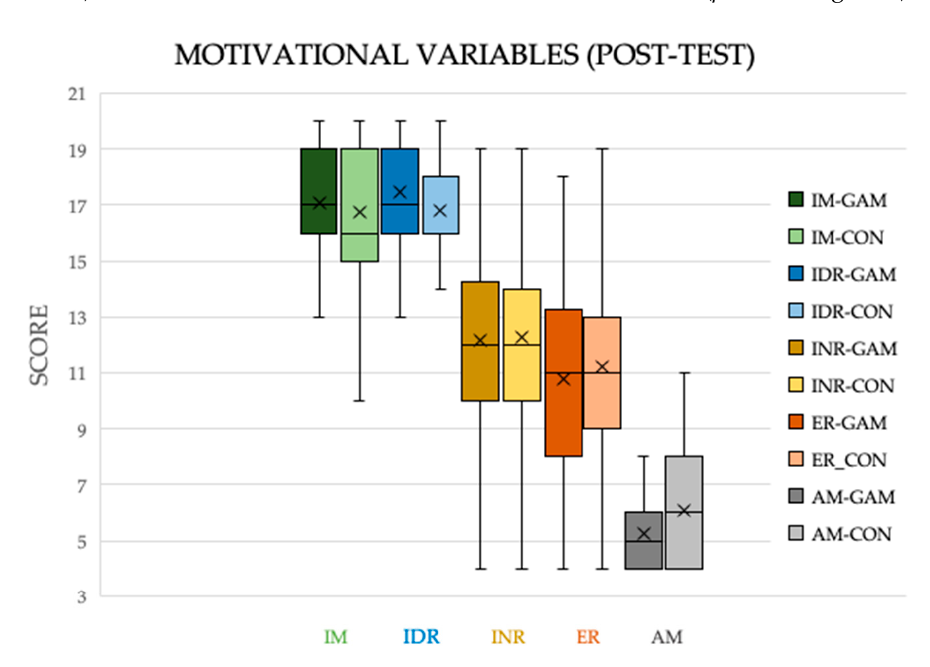
Figure 4. Box diagram of the motivational variables measured in a questionnaire CMEF (post-test).